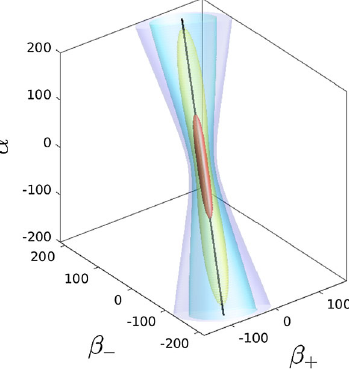
Fig. 1 Plot of equipotential surfaces of | (cid:2) | for a wave packet (cid:2) solv- ing the Wheeler–DeWitt Eq. (23). The thin black line is the classical